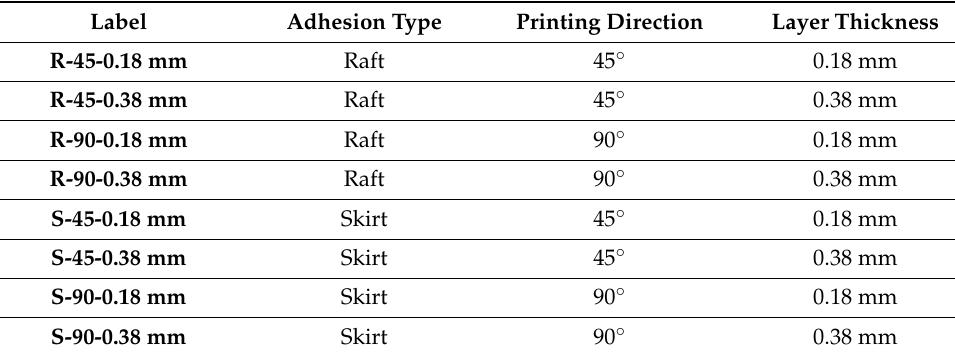
Figure 2. An illustrative drawing of the main 3D printing parameters varied and studied in this work including the printing direction, layer thickness, and adhesion type: ( a ) a sample on the print bed; ( b , c ) a comparison between two printing directions, 45° and 90°, respectively; ( d , e ) a comparison between two layer thicknesses, 0.18 mm and 0.38 mm, respectively; and ( f , g ) a comparison between the skirt and raft adhesion types, respectively. Table 2. A summary of the different types of 3D printed specimens considered in this study and their corresponding parameters.